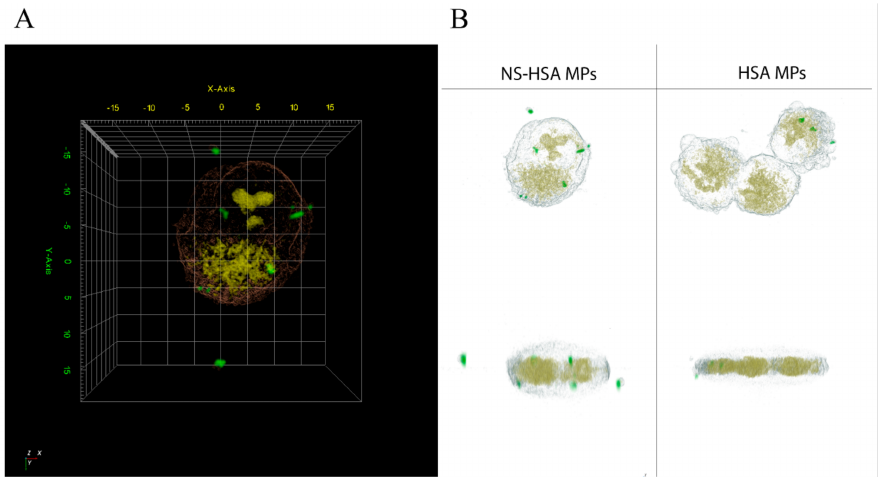
Figure 9. 3D RI tomogram of NS-HSA MPs ( A ) and HSA MPs that were internalized in A549 cells by fluorescence imaging together with RI imaging ( B ).